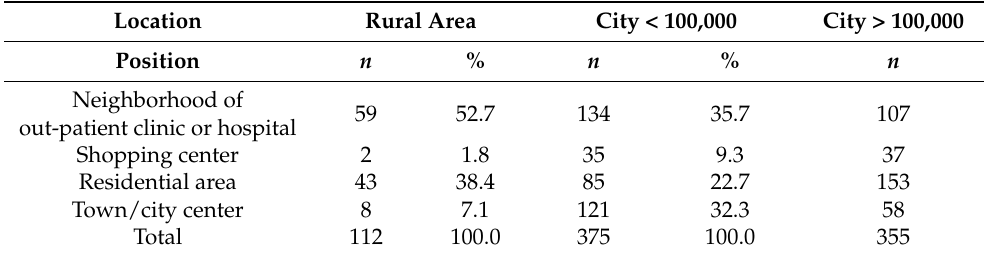
Table 2. The distribution of the studied pharmacies based on their location and position within the town/city.